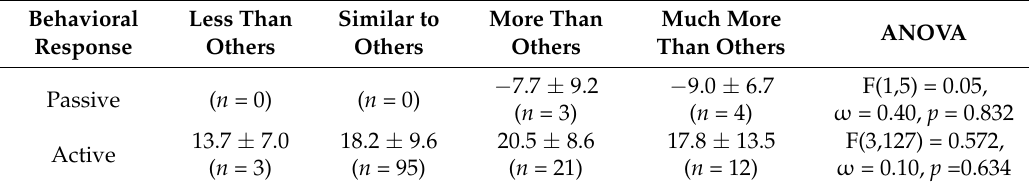
Table 2. Average calculated behavioral response axis scores for participants in each normative category of the Adult/Adolescent Sensory Profile.